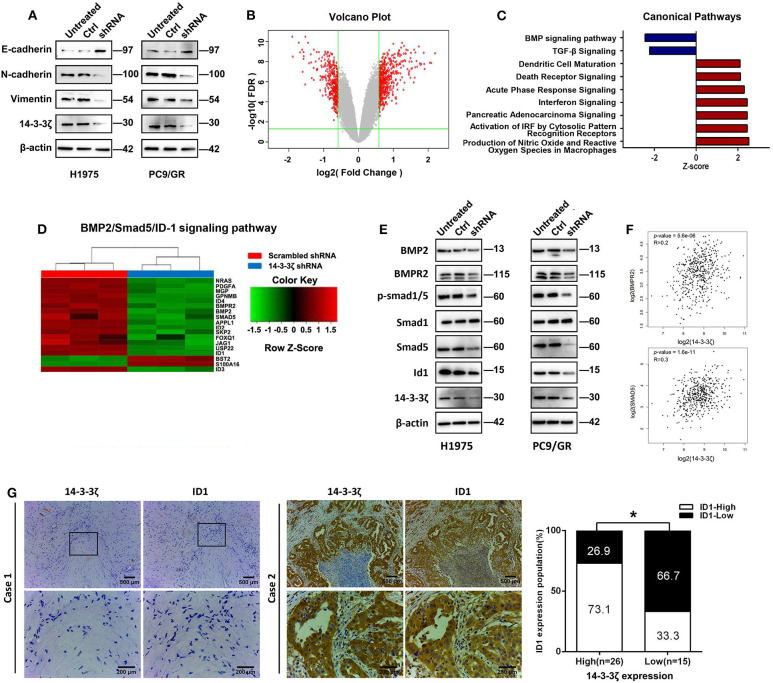
14-3-3ζ knockdown inhibits epithelial-to-mesenchymal transition (EMT) and the bone morphogenetic protein (BMP) pathway in EGFR-TKI-resistant cells. (A) Western blot analysis of E-cadherin, N-cadherin, and vimentin expression in EGFR-TKI-resistant cells and 14-3-3ζ-knockdown cells. β-actin was used as a loading control. (B) NCI-H1975 cells infected with lentivirus expressing either scrambled-shRNA or 14-3-3ζ-shRNA. Volcano plots are used to show genes with significant differences in data from two sets of samples. The abscissa is the multiple of the difference (logarithmic transformation with a base of 2), the ordinate is the significant false discovery rate (FDR; logarithmic transformation with a base of 10), and the red dots represent genes with significant differences. These genes were selected based on the absolute value of fold change ≥1.5 and FDR < 0.05. The gray dots represent other genes that have no significant difference. (C) The bar graph shows the significant enrichment of differentially expressed genes in the classical signaling pathways. According to IPA's internal algorithms and standards, a z-score ≥ 2 means that the pathway is significantly activated, and a z-score ≤ 2 means that the pathway is significantly inhibited. (D) Heatmap showing the differential expression of BMP2/Smad5/ID1 pathway gene signatures in NCI-H1975 cells infected with lentivirus expressing either scrambled-shRNA (blue) or 14-3-3ζ-shRNA (red). Genes and samples are listed in the rows and columns, respectively. A color key for the normalized expression data is shown at the top of the microarray heatmap (green represents downregulated genes; red represents upregulated genes). (E) NCI-H1975 and PC9/GR cells were transfected with 14-3-3ζ-shRNA (shRNA) or scrambled-shRNA (control) or were left untreated (untreated). The expression levels of BMP2, BMPR2, p-Smad1/5, Smad1, Smad5, and ID1 were determined using Western blotting. (F) The correlation between 14-3-3ζ and BMPR2 and Smad5 mRNA expression was identified by the TCGA database. (G) Representative images of immunohistochemical staining for 14-3-3ζ and ID1 in multiple sections of LUAD samples from patients. Patient 1 is representative of a patient with non-14-3-3ζ- overexpressing lung cancer, whereas Patient 2 is representative of a patient with 14-3-3ζ-overexpressing LUAD (left). There was a statistically significant correlation between the high expression of 14-3-3ζ and the high expression of ID1 in 41 LUAD tissues. The expression levels of 14-3-3ζ and ID1 were determined by immunostaining (right). Magnification, ×100; Scale bar = 500 μm. Magnification, ×400; Scale bar = 200 μm. *p < 0.05.